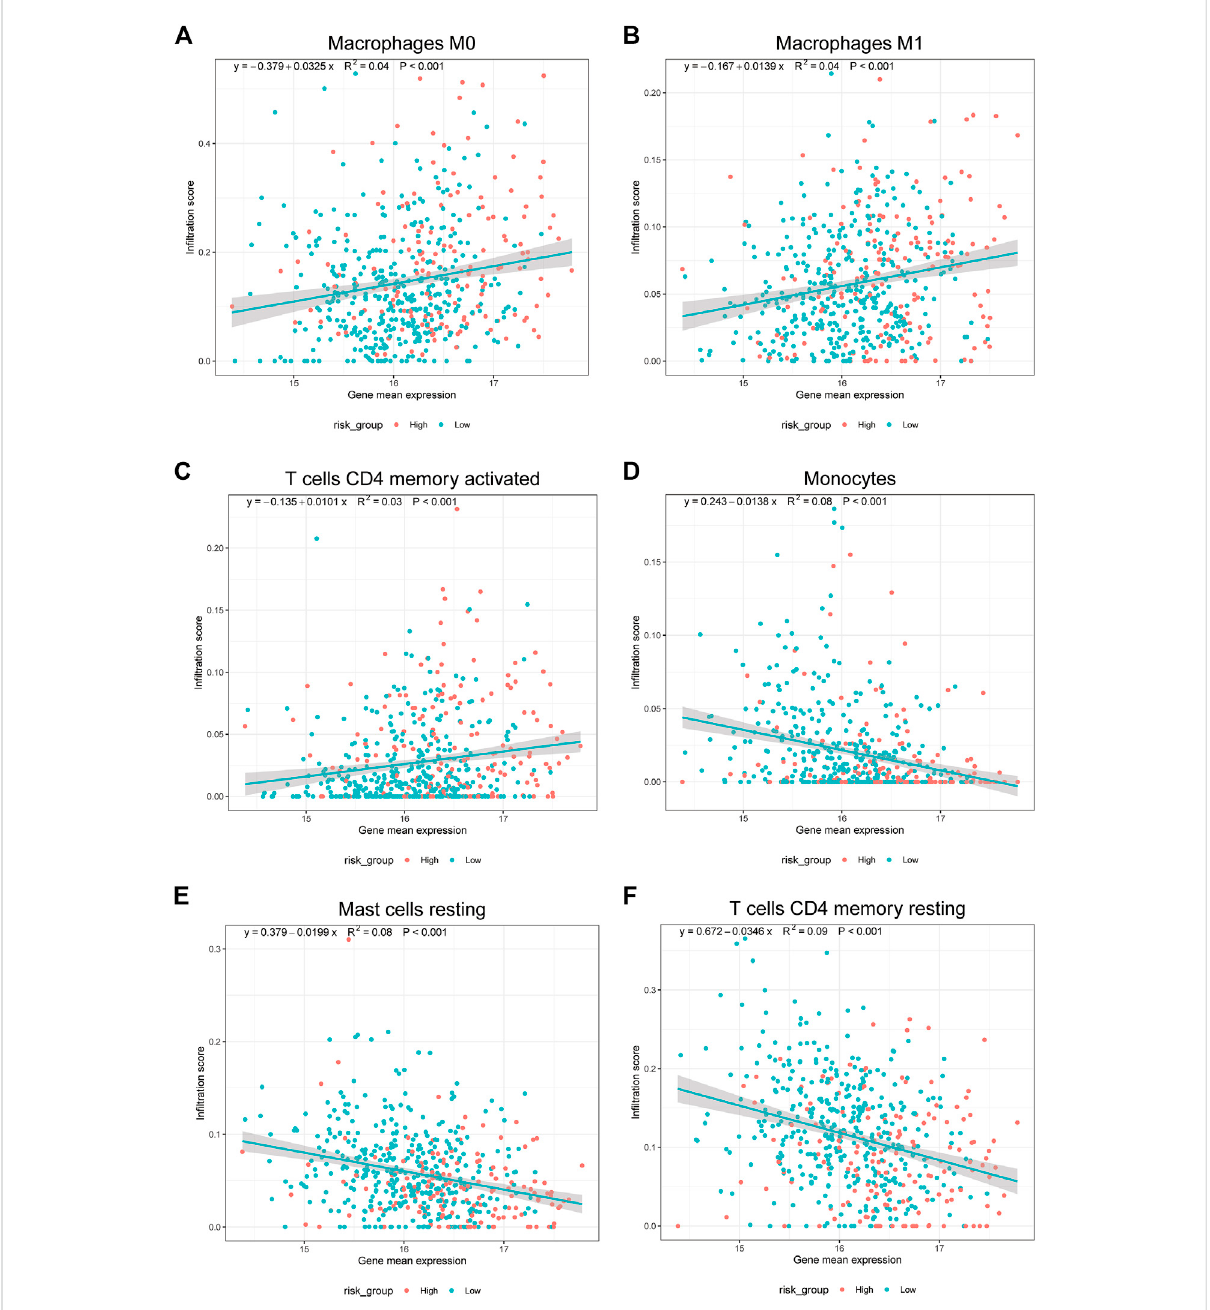
FIGURE 8 Prognosticmodel genes associated with immunecells. (A – F) . Correlation ofmean gene expressioninprognostic model with Macrophage M0, Macrophage M1, mast cell resting, Monocytes, T cells CD4 memory activated, T cells CD4 memory